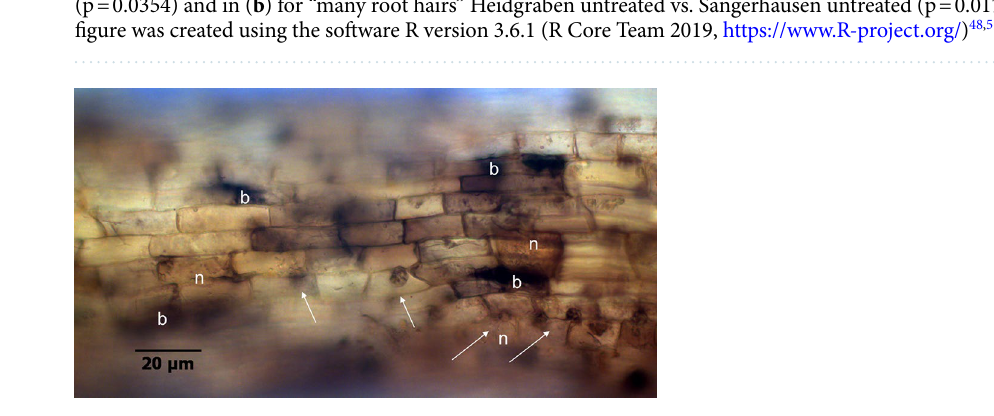
Figure 4. Cell necroses (n), blackening (b), and dark fungal structures in rhizodermal cells (arrows) in a fine root of R. corymbifera ‘Laxa’, after 9 weeks of cultivation in RRD soil from site